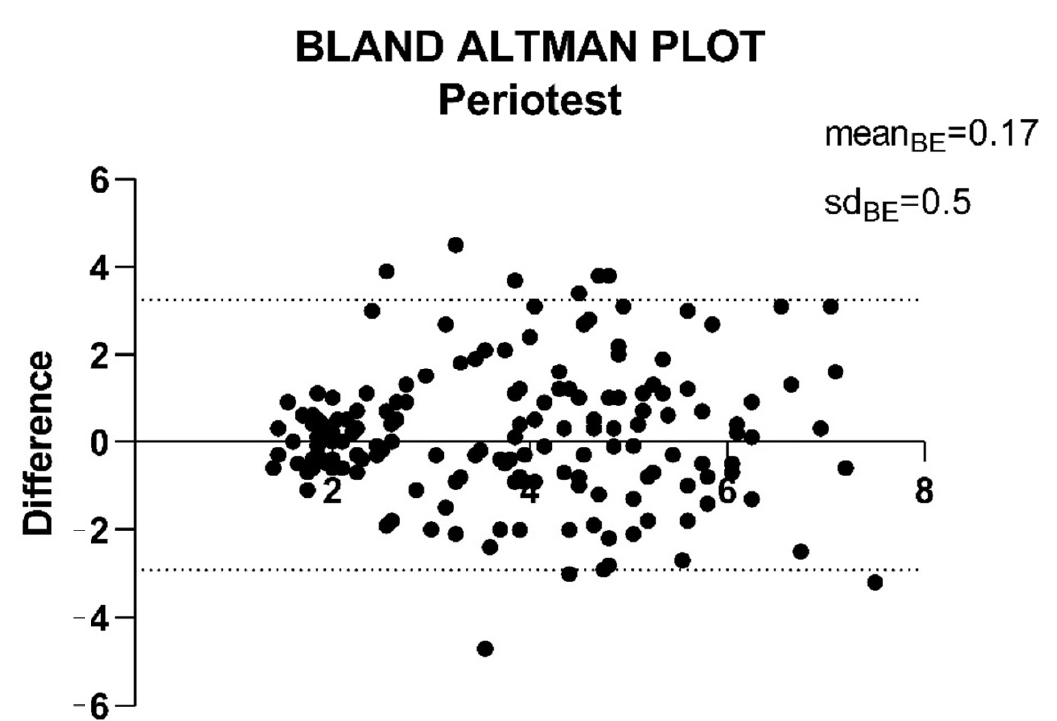
Figure 4. Insertion torque ( A ), removal ( B ) and Periotest analysis ( C ) study outcome. Means and standard deviations are presented in tables ( p < 0.05).